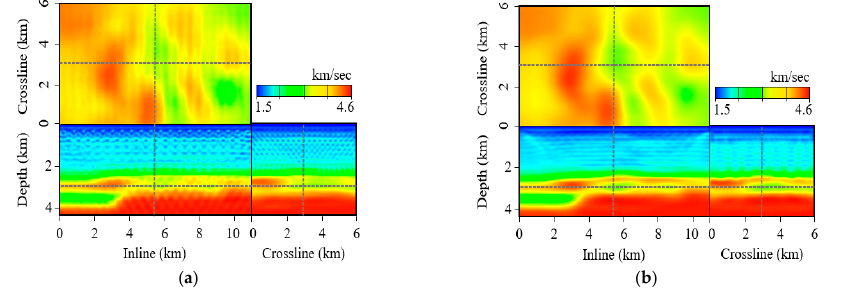
Figure 6. The inverted velocity model from FWI with ( a ) mode I (conventional) and ( b ) mode IV (large-angle) of DAF for baseline survey.